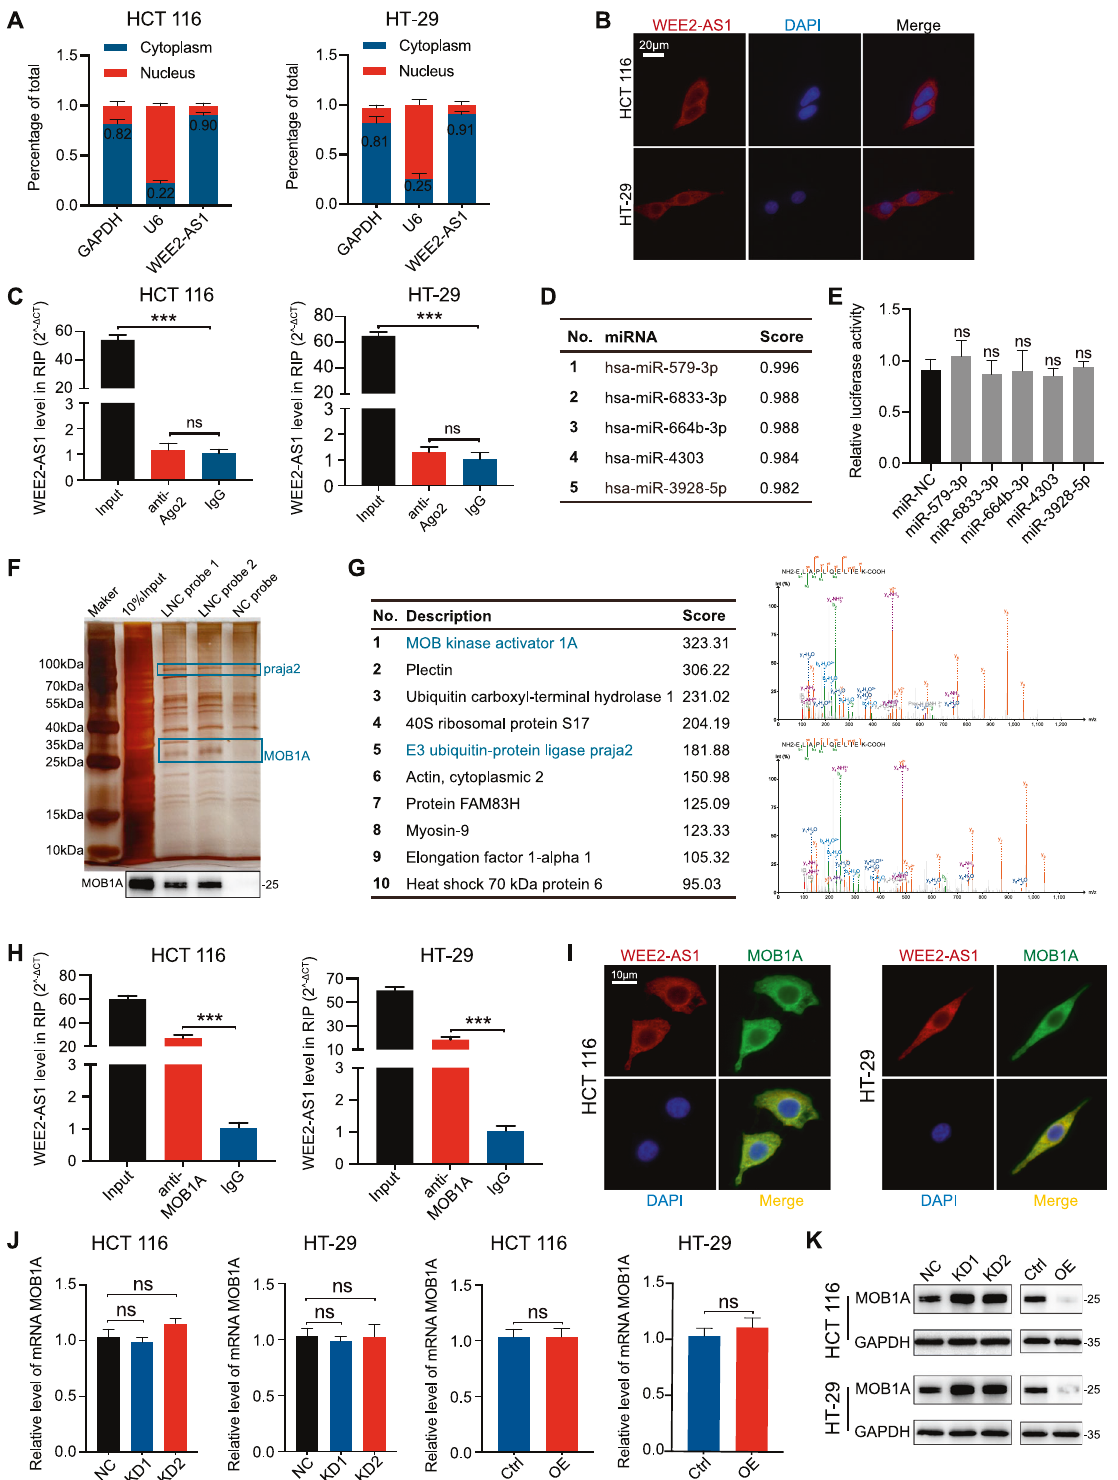
Fig. 4 WEE2-AS1 is predominantly localized in the cytoplasm and directly interacts with MOB1A. A , B Subcellular fractionation assays and RNA-FISH con fi rm that WEE2-AS1 is predominantly located in the cytoplasm (scale bar: 20 μ m). C Level of WEE2-AS1 detected by qRT-PCR after RIP for Ago2 in HCT 116 and HT-29 cells. D The top fi ve miRNAs are predicted from LncBase Experimental v.2. E The luciferase reporter plasmid (RLuc-WEE2-AS1) was cotransfected into HEK-293T cells with the 5 various miRNA-coding plasmids. F Silver staining of WEE2-AS1 pulldown. Blue boxes show different bands between the WEE2-AS1 and NC probe. G List of the top 10 differentially expressed proteins identi fi ed by mass spectrometry. The amino acid sequence of a doubly charged peptide was identi fi ed as NH2-ELAPLQELIEK-COOH, and a Mascot search showing the peptide matched with MOB1A. H Level of WEE2-AS1 detected by qRT-PCR after RIP for MOB1A in HCT 116 and HT-29 cells. I Dual RNA-FISH and immuno fl uorescence assays: WEE2-AS1(red), MOB1A(green) (scale bar: 10 μ m). J , K . qRT-PCR and western blot for MOB1A expression. Data are shown as mean ± SD of three independent experiments, *** P < 0.001, ns. not signi fi cant. Cell Death and Disease (2022)